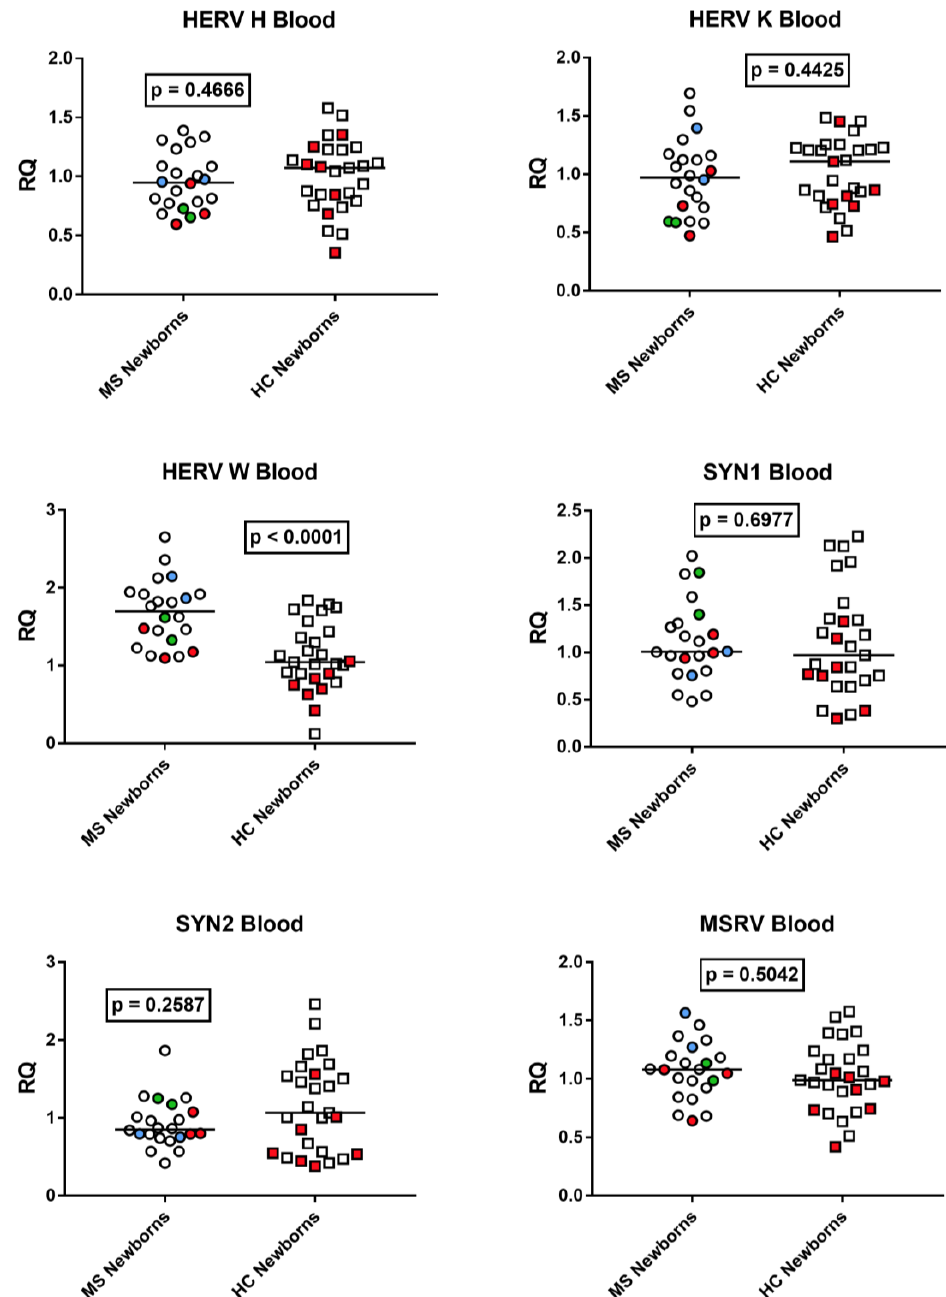
Figure 8. Expression of pol genes of HERV-H, -K, and -W and of env genes of Synctyn (SYN) 1, SYN2, and of multiple-sclerosis-associated retrovirus (MSRV) in cord blood from 22 neonates born to 20 mothers with multiple sclerosis (MS) and from 27 neonates born to healthy control (HC) mothers. RQ: relative quantification. Circles and squares show the mean of three individual measurements; horizontal lines show the median values. Premature deliveries are shown in red; these include two pairs of twins in blue and green. Medians and IQR 25–75%: HERV-H- pol Group A (mothers with MS) 0.95, 0.76–1.09; Group B (unaffected mothers) 1.07, 0.82–1.23; HERV-K- pol : Group A 0.97, 0.72–1.15; Group B 1.11, 0.81–1.24; HERV-W- pol : Group A 1.67, 1.34–1.92; Group B 1.04, 0.87–1.40; SYN1- env : Group A 1.01, 0.84–1.30; Group B 0.97, 0.73–1.35; SYN2- env : Group A 0.85, 0.76–1.06; Group B 1.07, 0.56–1.55; MSRV- env : Group A 1.08, 0.94–1.19; Group B 0.99